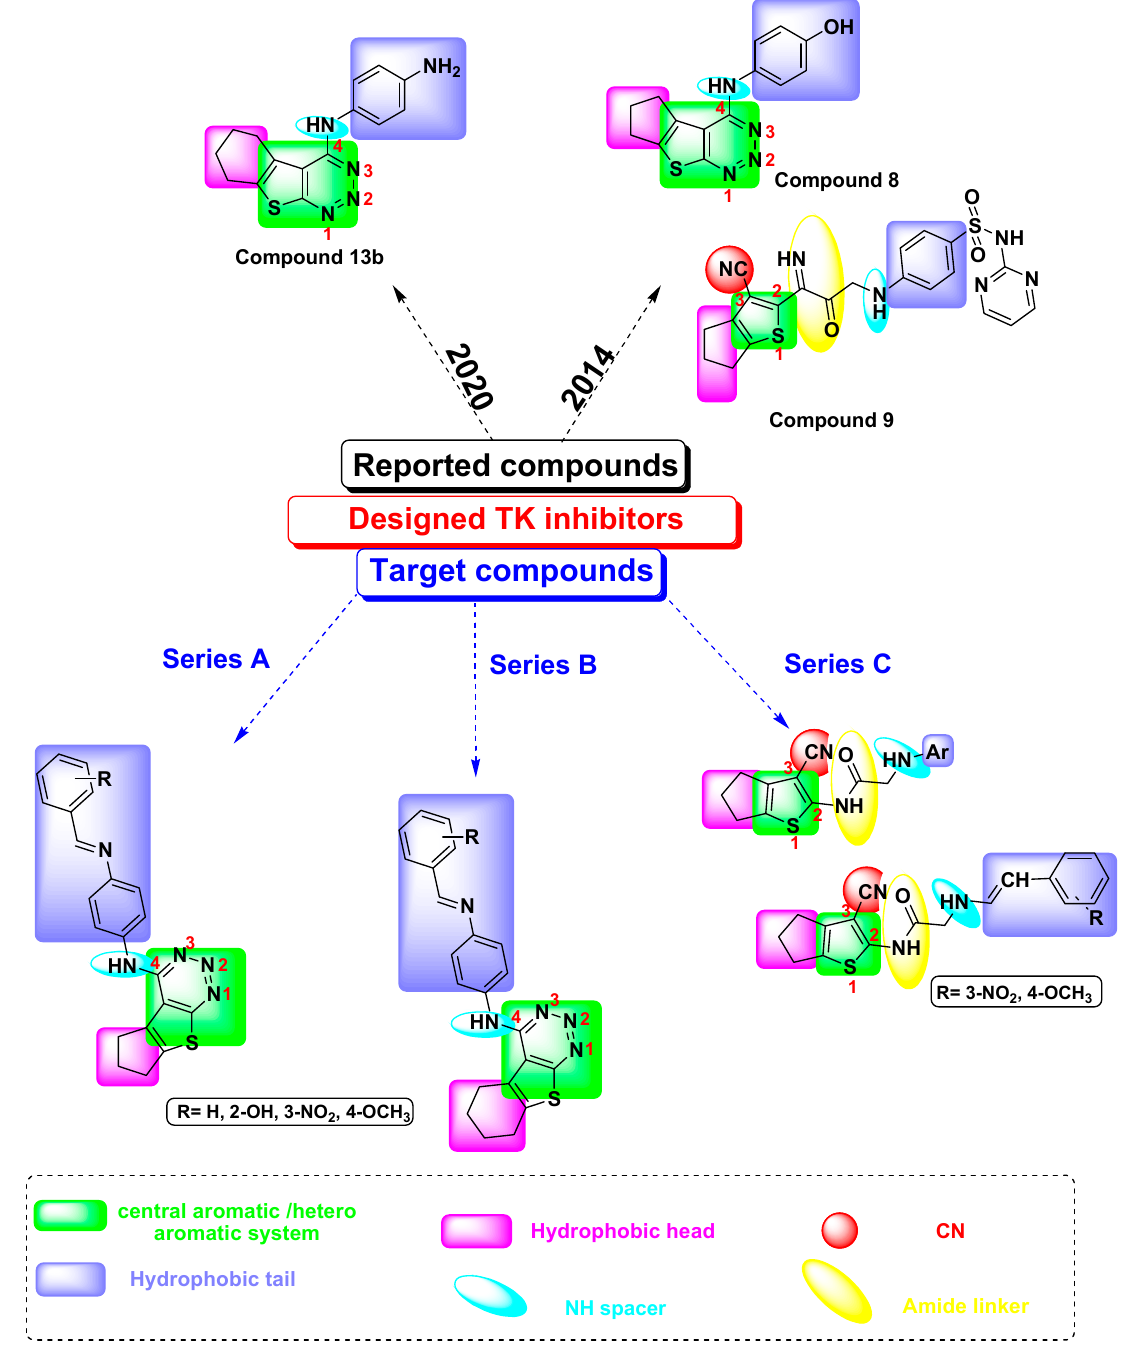
Figure 2. Reported and designed derivatives as dual epidermal growth factor receptor (EGFR)/human EGFR-related receptor 2 (HER2) inhibitors targeting H1299.